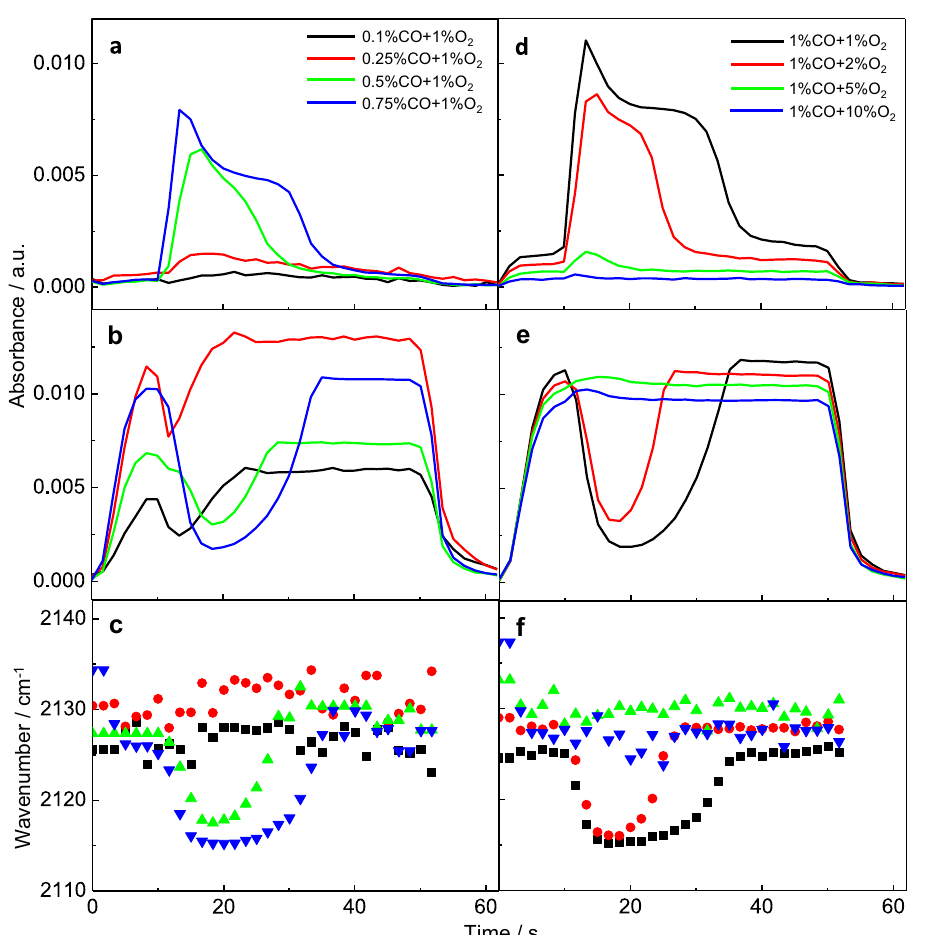
Fig.2|VariationoftheIRintensityandwavenumberofCO-AuandCO 2 against time during CO oxidation in different concentrations of CO and O 2 . a , d Var- iation of the IR intensity of CO-Au against time; b , e Variation of the IR intensity of CO 2 against time; c , f plots of the maximum intensity of CO against time in different concentrations of CO and O 2 . The signals were corrected by